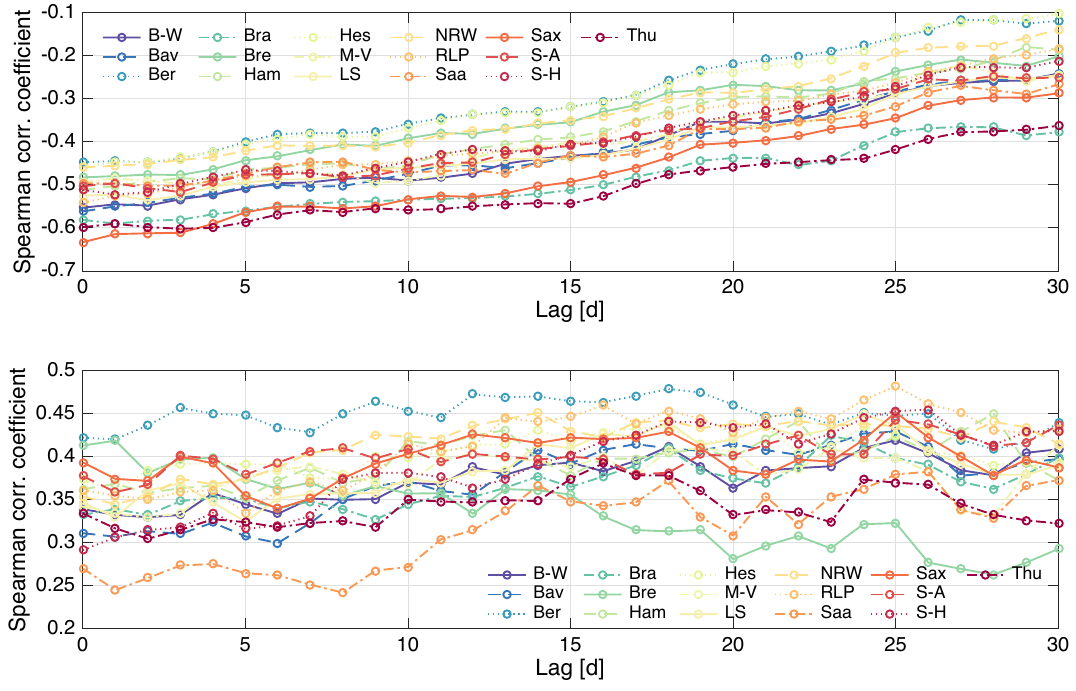
Figure 4. Spearman-rank correlation coefficients between daily cases from all states in Germany with the average temperature (above) and average humidity (below) on a moving window of 290 observations. Averaging throughout the states obtains the minimum of − 0.5223 (temperature) and maximum of 0.4194 (humidity) corresponding to the lags 0 and 25,